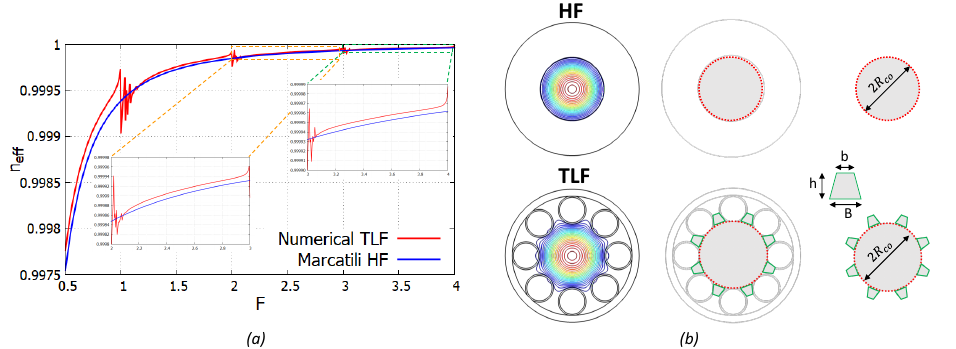
Figure 1. Hole fiber (HF) and tube lattice fiber (TLF) comparison. ( a ) FM dispersion curves; ( b ) field profiles and core geometry.